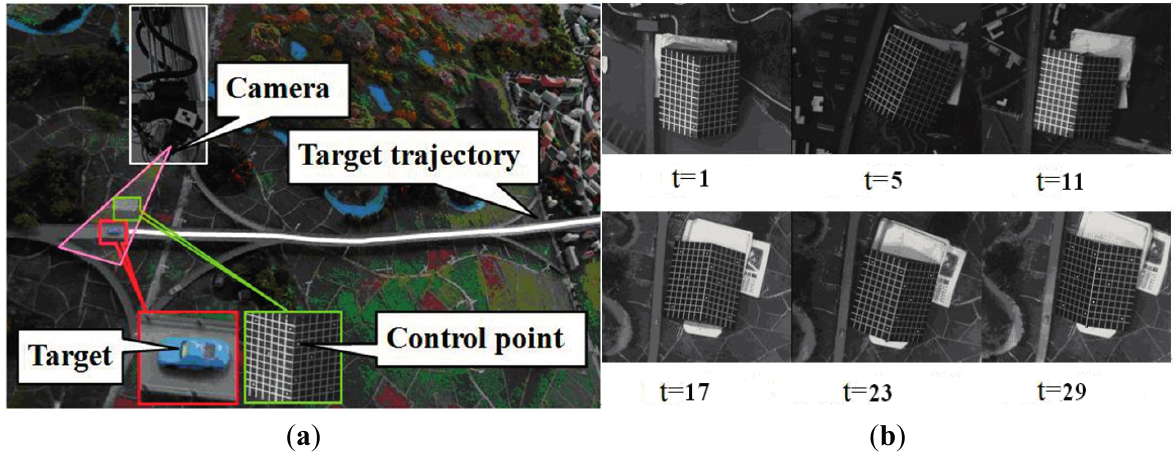
Figure 8. Experimental scene of 3D trajectory. ( a ) An apparatus for the reconstruction of toy car trajectory; ( b ) The part images of sequence for 3D reconstruction.